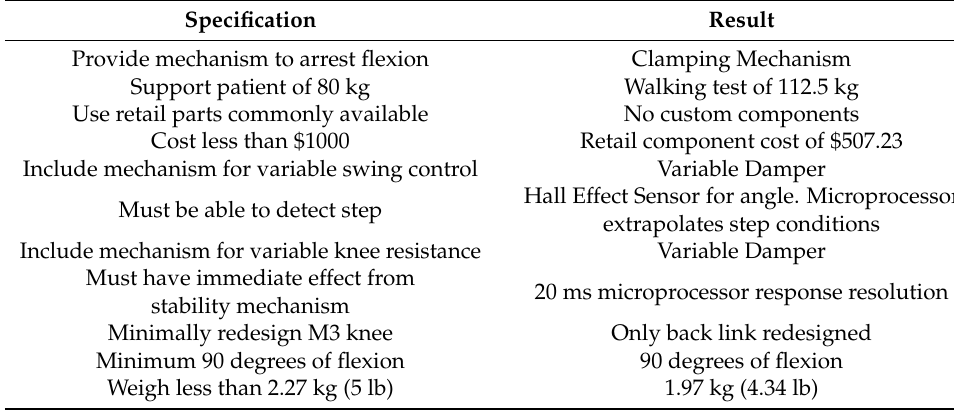
Table 3. Design specifications vs. results of